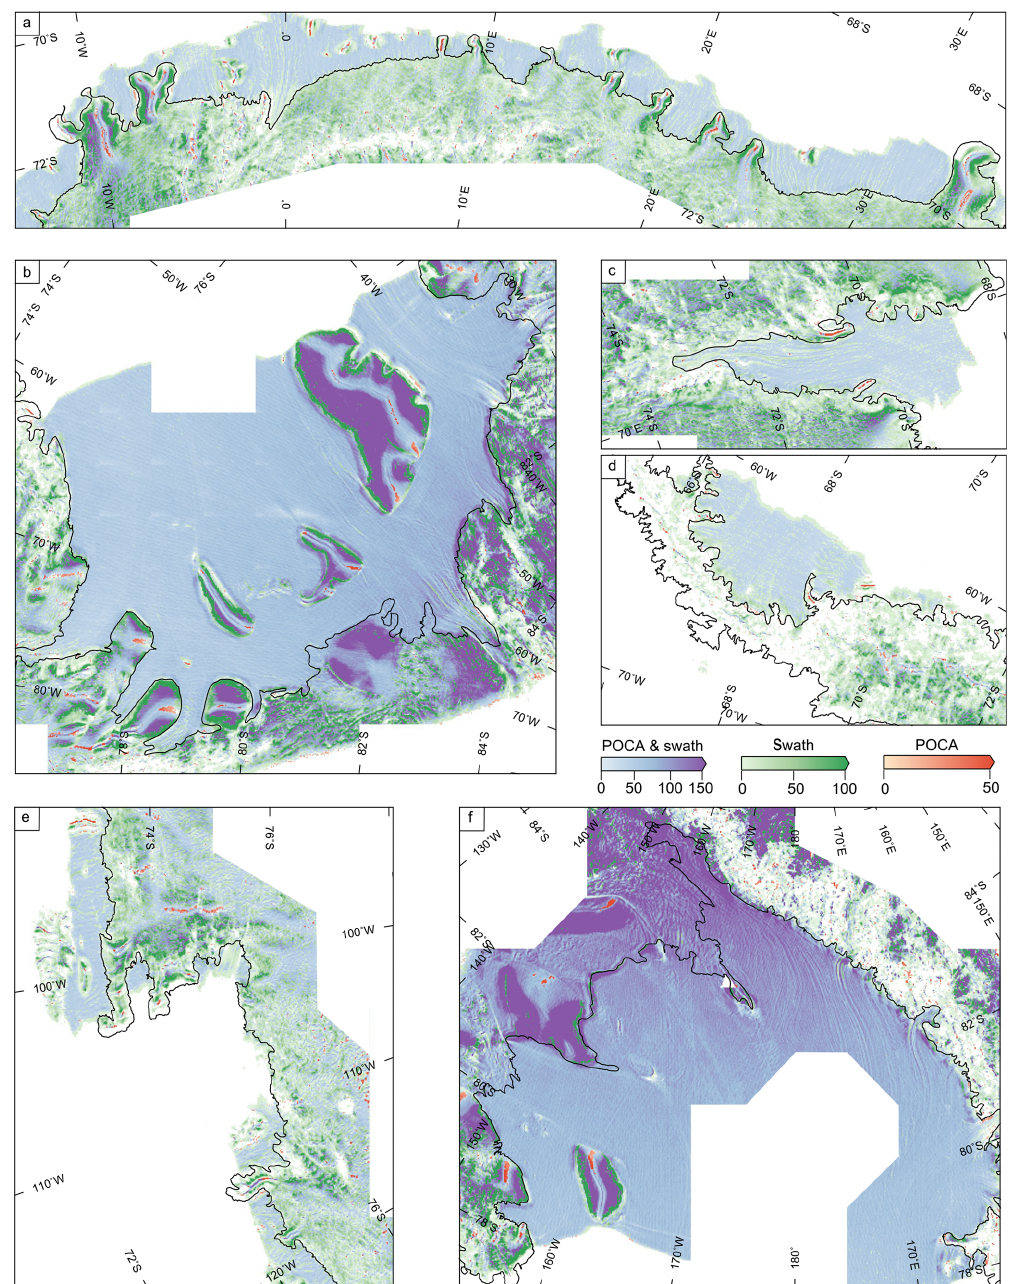
Figure A1. Data coverage plot for POCA and swath data. Red, green and blue data points correspond to where we used POCA, swath or both to calculate T d , respectively. The colour scales shows the data density (POCA points per km). The swath data density is scaled by 150 (the average number of swath to POCA data points) to match the POCA density for (a) Dronning Maud Land, (b) Filchner–Ronne Ice Shelf, (c) Amery Ice Shelf and (d) Antarctic Peninsula. (e) Amundsen Sea sector and (f) Ross Ice Shelf. The black line is a composite grounding line by Depoorter et al.